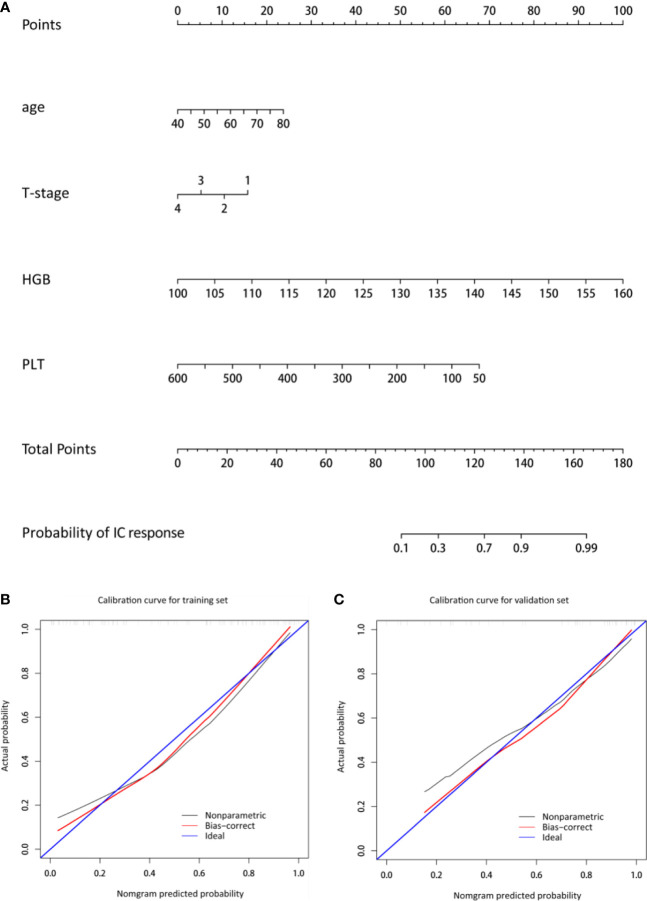
Nomogram and the corresponding calibration curve. (A) The nomogram was developed with age, T-stage, HGB, and PLT incorporated. (B, C) The calibration curves of the nomogram in the training and cross-validation data sets. The x- and y-axes are the nomogram-predicted probability and actual probability of IC response, respectively. The red line represents the performance of the nomogram, and the blue line represents a perfect prediction by an ideal model. A closer fit to the diagonal blue line represents a better prediction. HGB, hemoglobin; PLT, platelet.